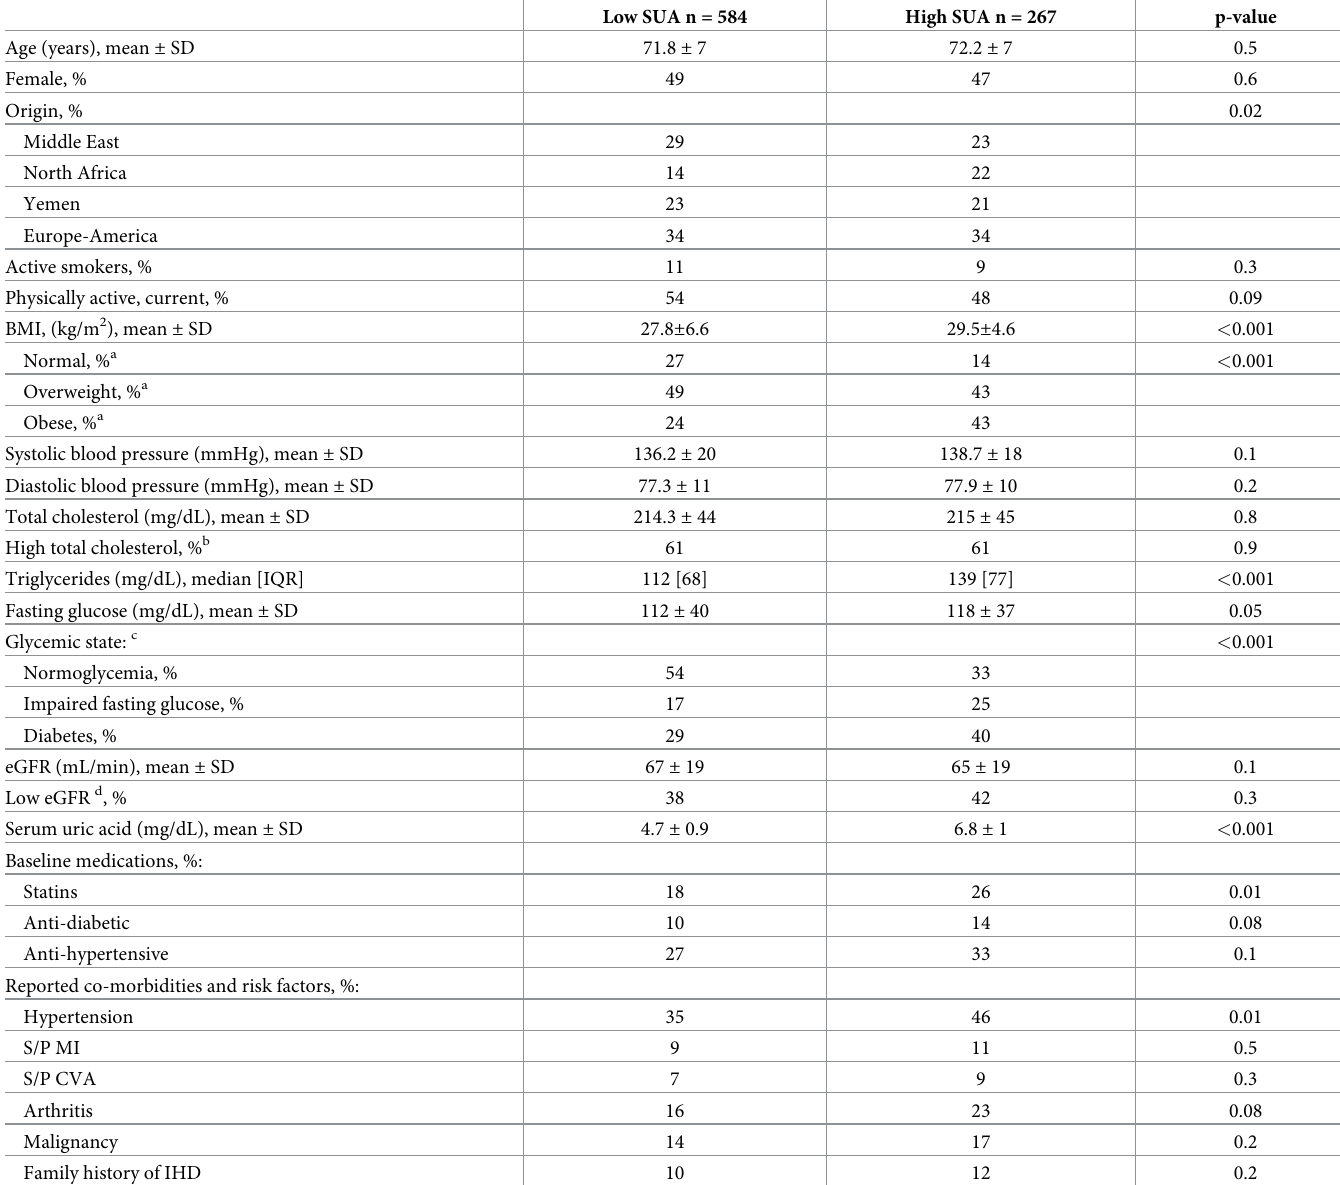
Table 1. Baseline characteristics of 851 community dwelling elderly men and women according to serum uric acid * upper vs. two lower tertiles ‡